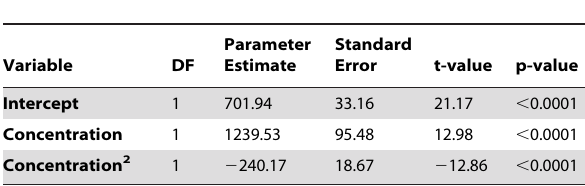
Table 1. Linear regression parameter estimates